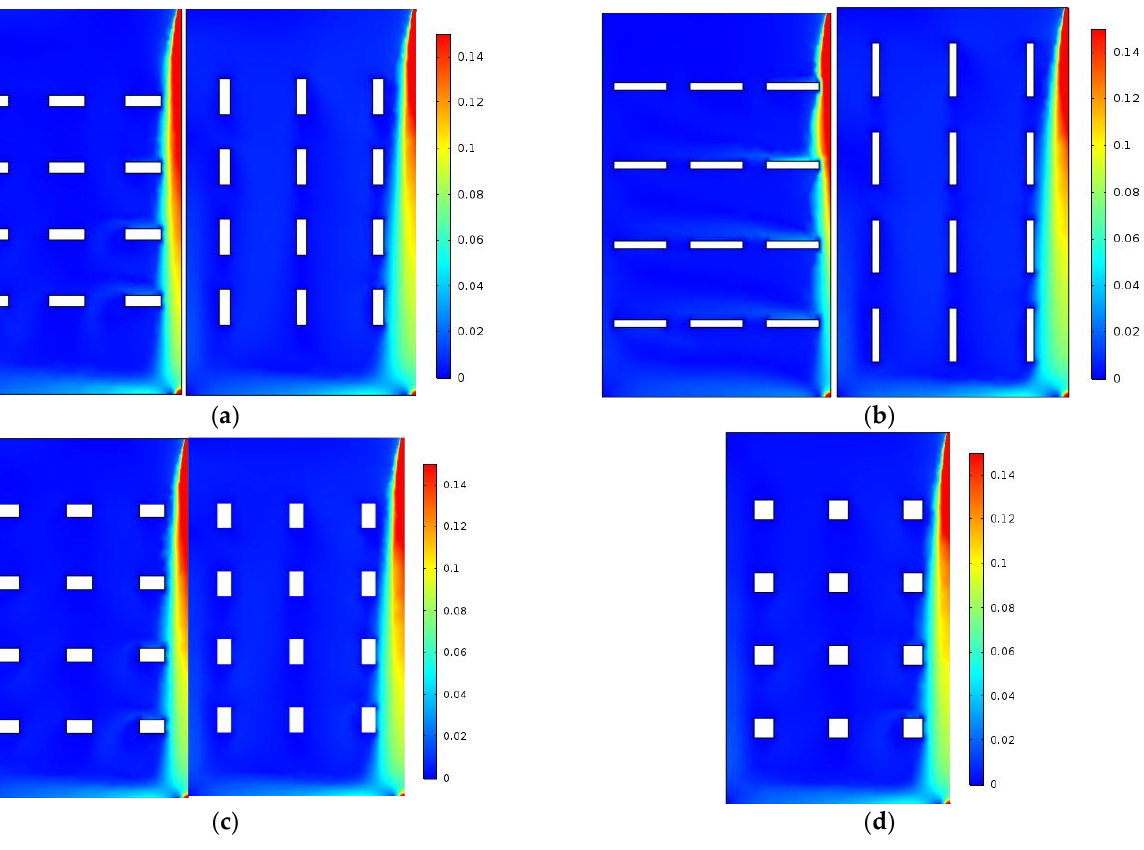
Figure 18. Flow field distribution chart of a reservoir under different phase change heat storage module sizes: ( a ) section size 100 mm × 30 mm, 30 mm × 100 mm; ( b ) section size 150 mm × 20 mm, 20 mm × 150 mm; ( c ) section size 75 mm × 40 mm, 40 mm × 75 mm; and ( d ) section size 57.44 mm × 57.44 mm.